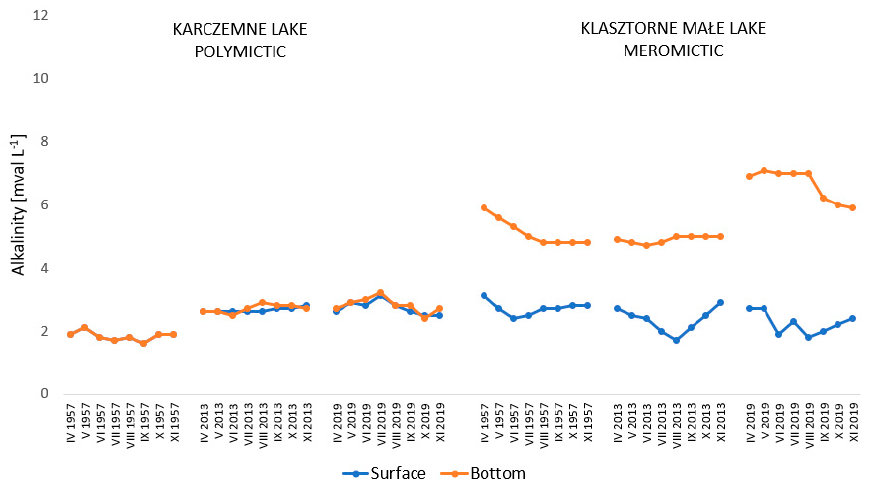
Figure 8. Changes in alkalinity values in the water of Karczemne and Klasztorne Małe lakes in selected research years.